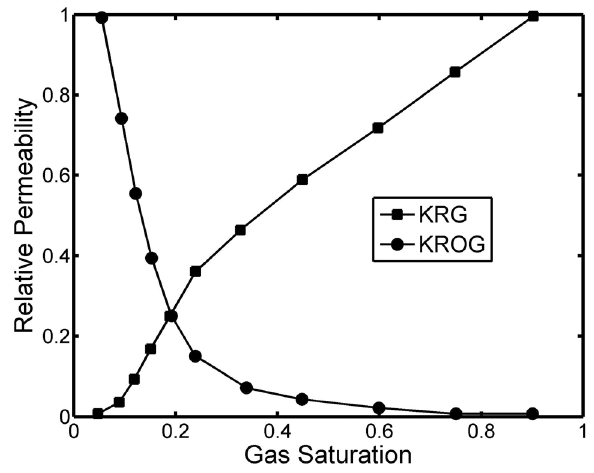
Fig. 5 Relative permeability curves for the oil–gas (KROG) system Fig. 6 Relative permeability curves for the water–oil (KROW)